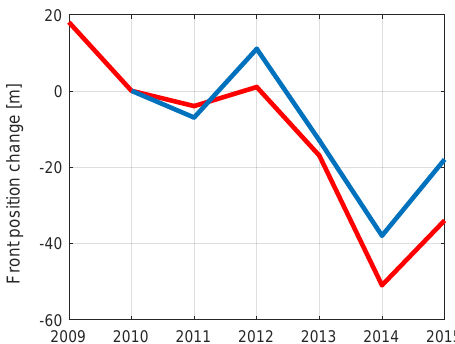
Figure 9. Front position of Juvfonne measured at two locations rel- ative to the 2010 front. Minima are observed in 2011 and 2014. The front retreat 2009–2014 was measured to 69m. For position of measurements, see Fig. 3a. Red – JF1, blue – JF2. Figure 10. Meteorological data from the station at Juvvasshøe